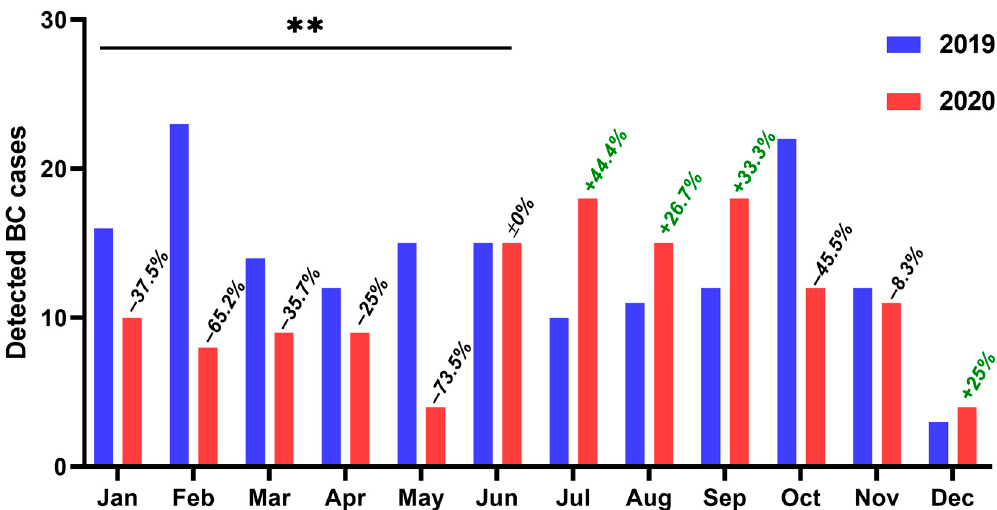
Figure 2. Total number of diagnosed bladder cancer cases in 2020, compared with 2019. ** p < 0.01.